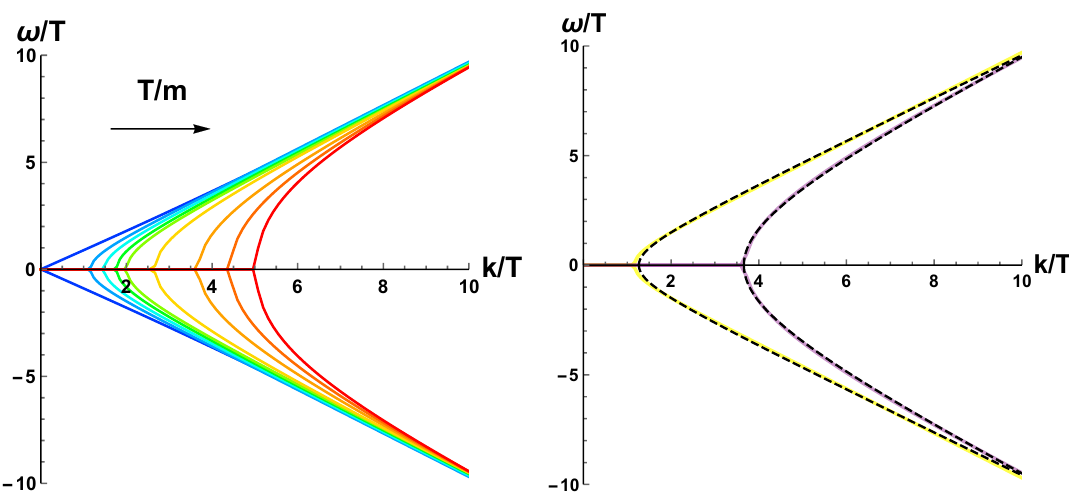
Figure 12 . Left: a collection of dispersion relations exhibiting the k-gap for increasing temperature. Right: some benchmark results for the (cid:12)t ! = expected value (cid:23) = 1 = 2 and a is compatible, up to numerical error, to the relativistic limit a = 1 which is always reached at large momentum k=T (cid:29)